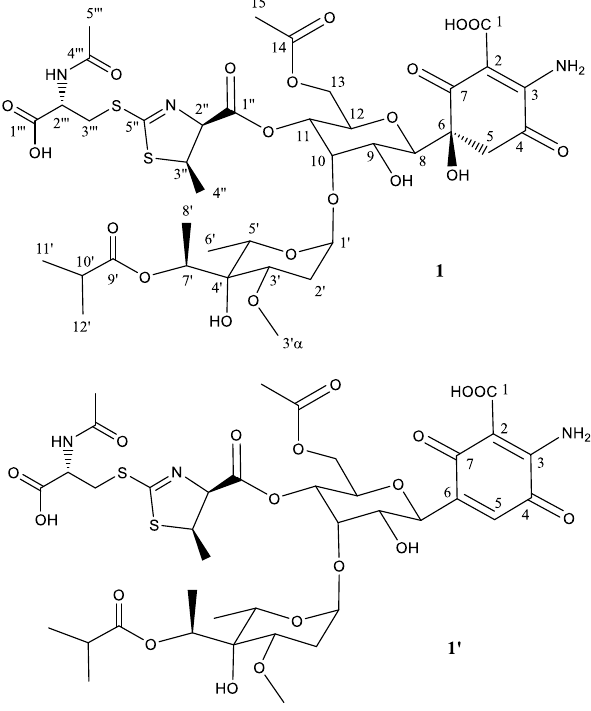
Figure 2. Structure of compound 1 deduced from 1 H- and 13 C-NMR data and proposed structure of secondary product compound 1’ after abstraction of one molecule of H 2 O.